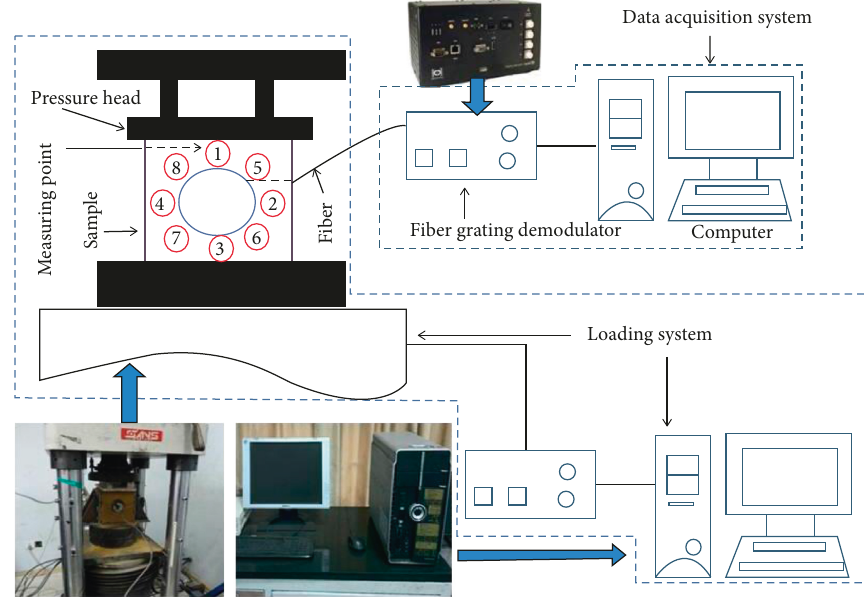
Figure 1: Experimental